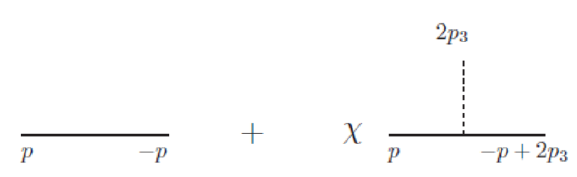
Figure 1 . Scalar propagator for mixed boundary conditions. Dashed line represents the momentum re(cid:13)ected from the boundary. In this notation p 3 = (0 ; p 3